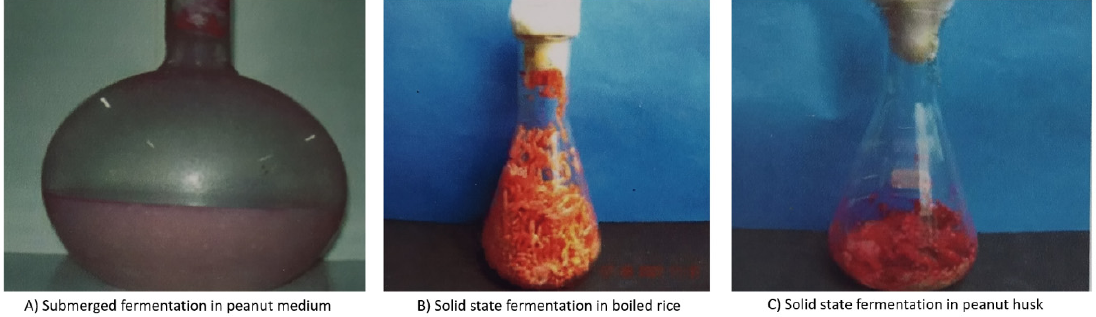
Figure 4. Growth of Monascus sp. in di ff erent agro substrates. ( A ) Submerged fermentation in peanut medium; ( B ) Solid state fermentation in boiled rice; ( C ) Solid state fermentation in peanut husk.